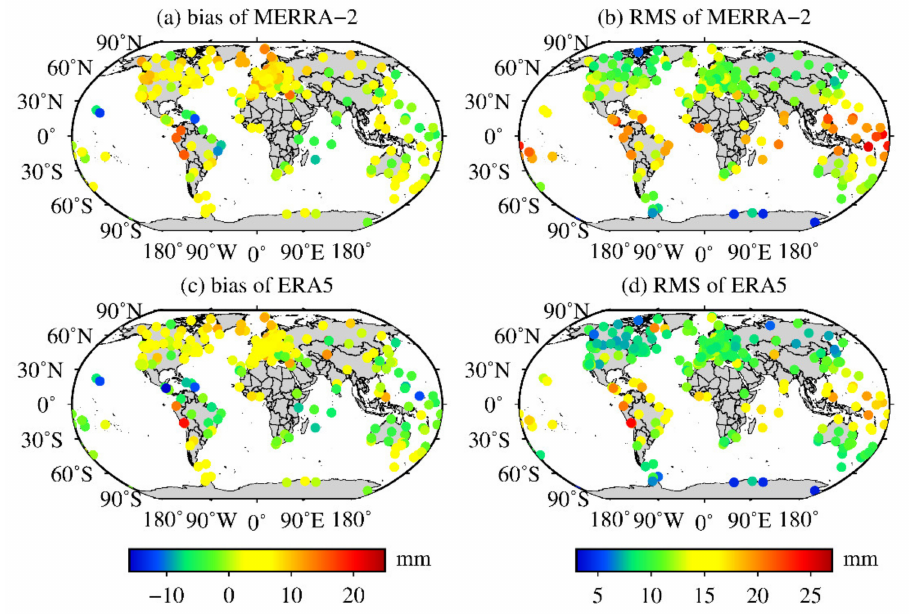
Figure 7. Distributions of the annual mean ( a , c ) bias and ( b , d ) RMS values of the ZTD derived from ERA5 and MERRA-2 pressure-level data compared to the GNSS ZTD from 2016 to